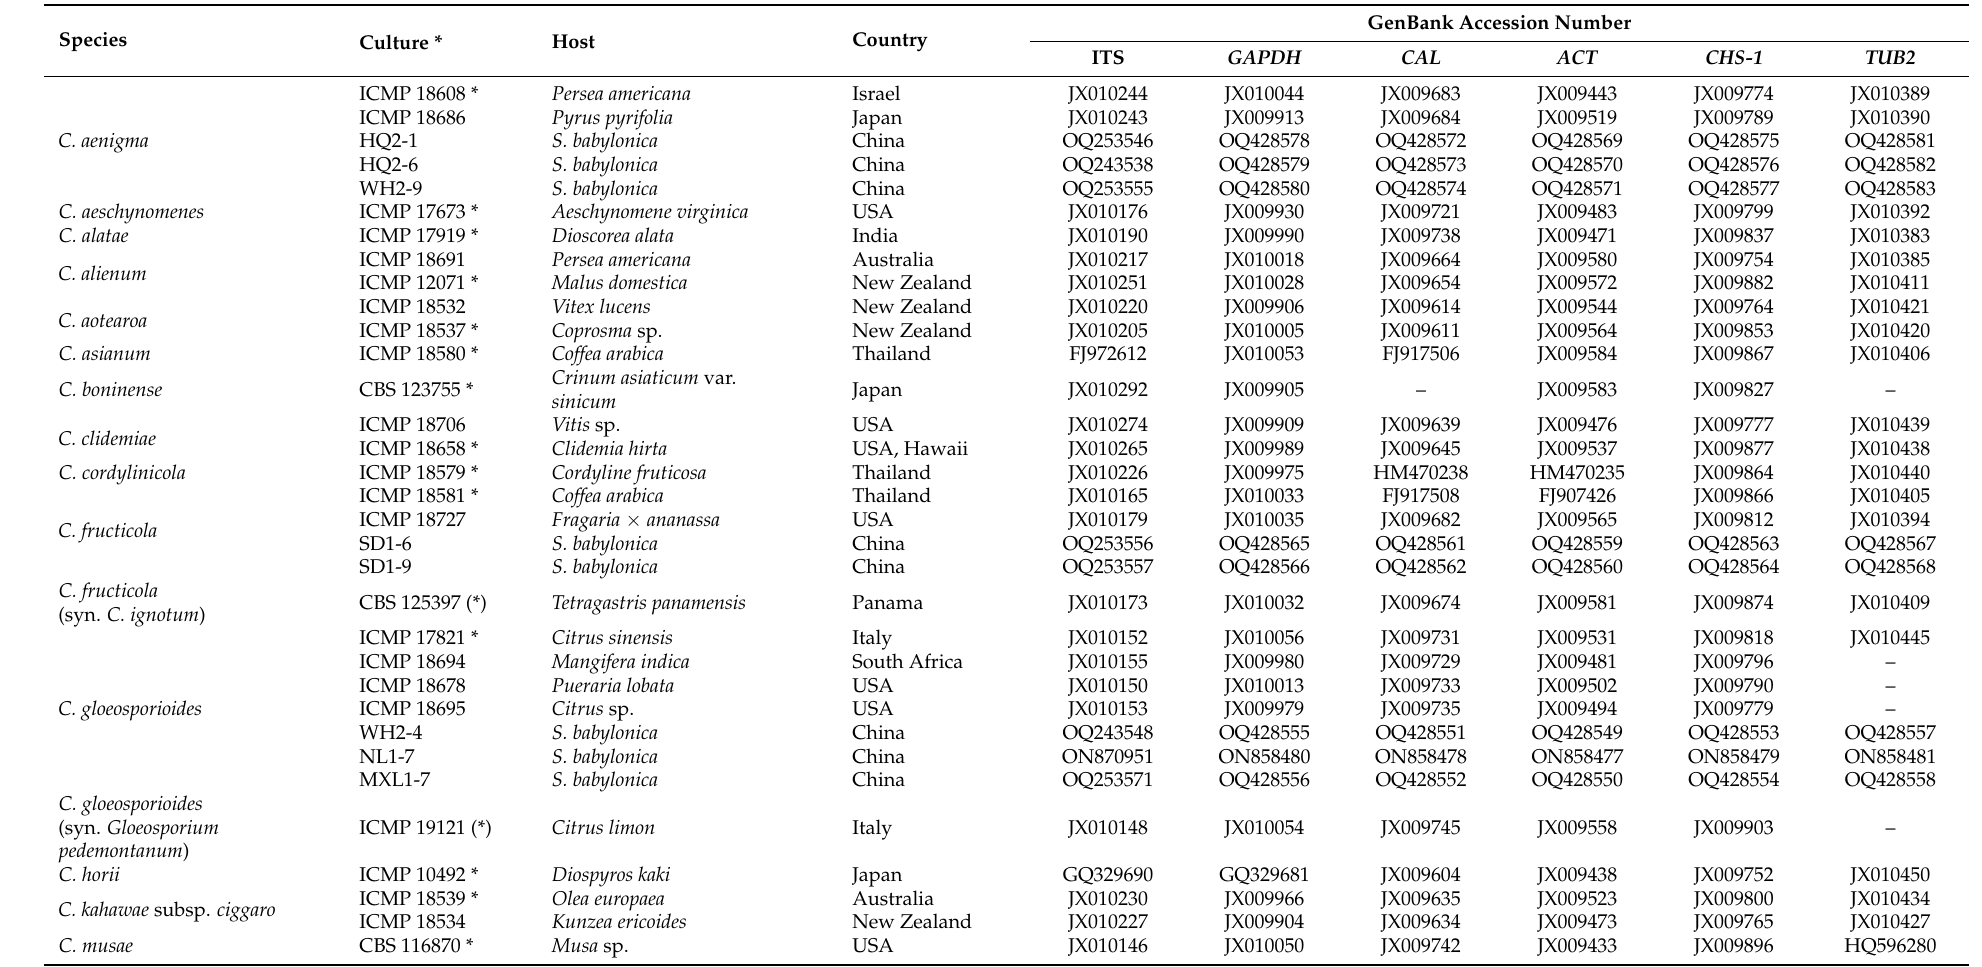
Table 4. A list of isolates of Colletotrichum spp. collected from Salix babylonica leaves in China as well as related taxa/isolates and their sequences used in this study.